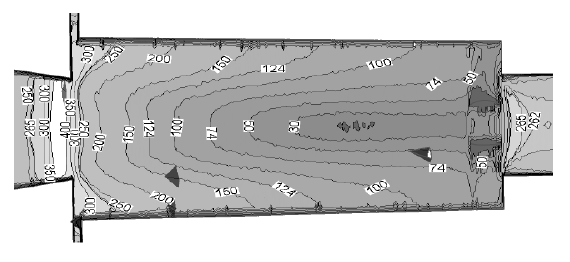
Figure 16. Computed plots of velocity magnitude (m/s) of hot end at RNG k-epsilon 5 bar.